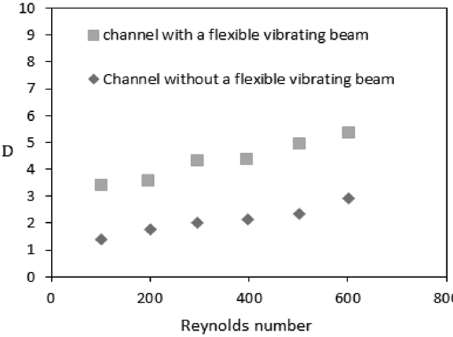
Fig. 12 Comparison of relative Nusselt number versus Reynolds number for the channel with and without elastic vibrating beam (BR = 0.6, θ = 135°)